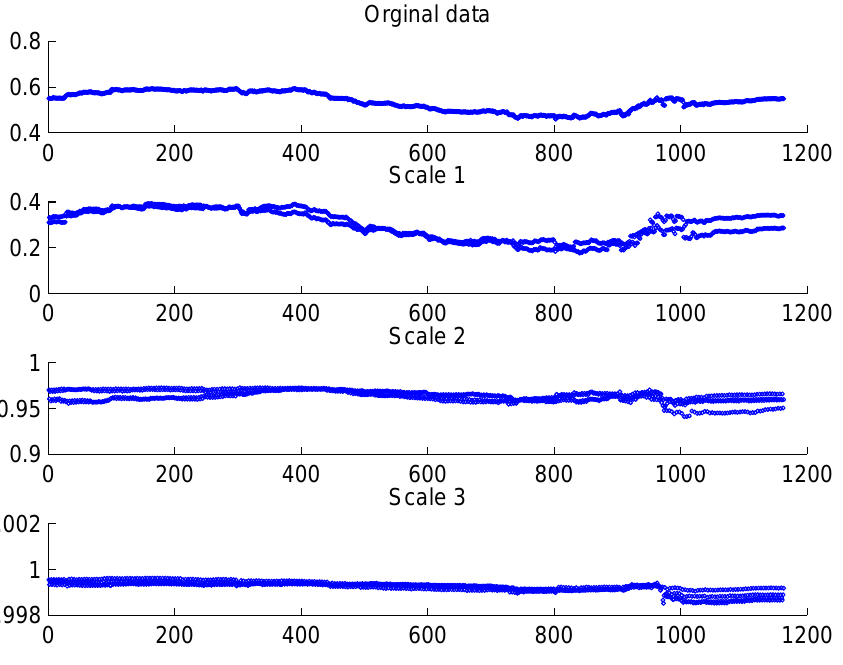
Figure 2. Dynamic correlation between WTI and Brent markets at different